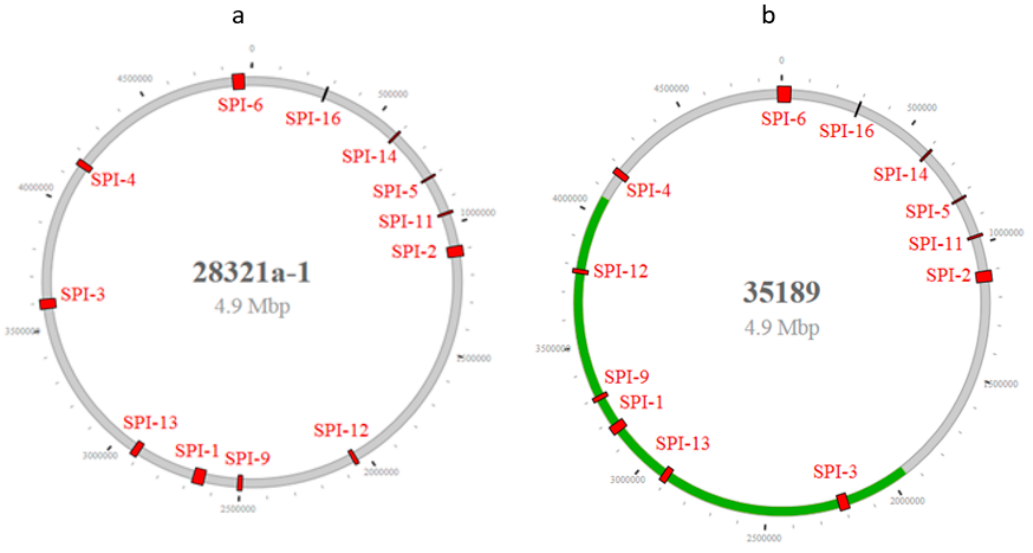
Figure 2. ( a ) . Presence and distribution of SPIs in S . Typhimurium (28321a) and ( b ). S . Reading (35189) genomes. Green line indicated that a DNA segment linked with the SPI-3 / SPI-13 / SPI-1 / SPI9 / SPI-12 sequences had a changed orientation compared with other serotypes. Table 2. Identified antimicrobial, biocide, and heavy metal resistance genes from 450 Salmonella strains. Resistance